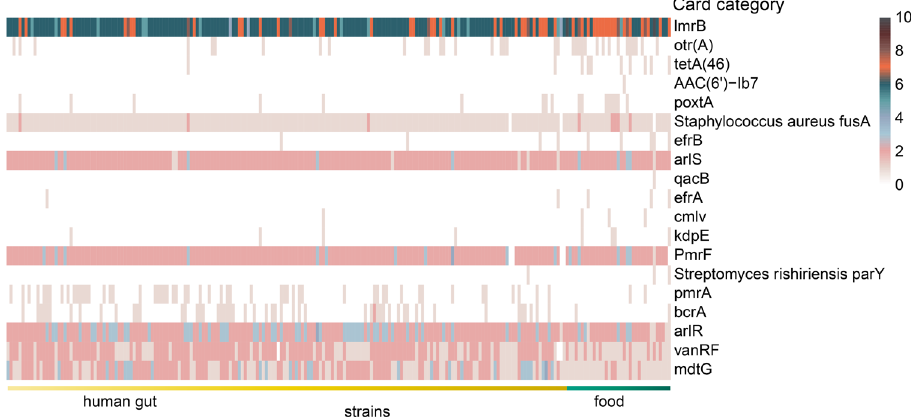
Figure 6. Heatmap of the number of differential antibiotic resistance genes annotated with the comprehensive antibiotic resistance database in the genome of L. fermentum from human gut and food. (The items of antibiotic resistance gene with LDA score greater than 2 using linear discriminant analysis effect size analysis are listed).